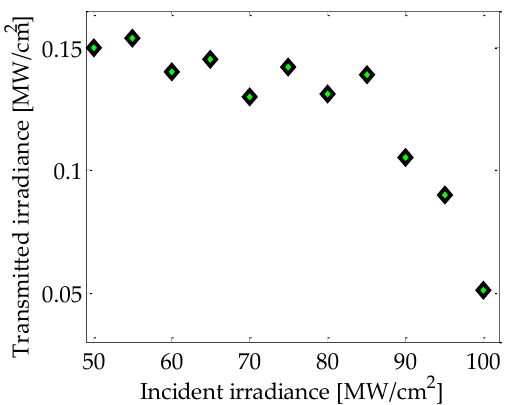
Figure 4. Experimental results for the transmitted irradiance vs. incident irradiance in the sample interacting with nanosecond pulses at 532 nm wavelength.